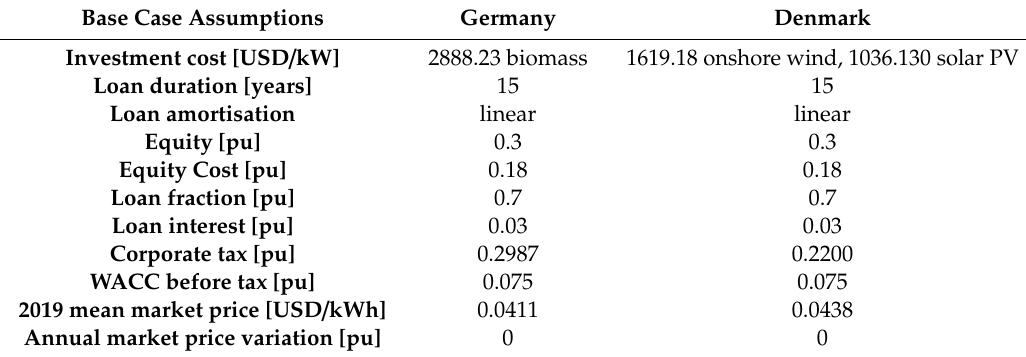
Table 3. Base case assumptions for the determination of the project and equity net present value (NPV) and internal rate of return (IRR) of the German biomass and the Danish onshore wind and solar photovoltaics (PV) auctions listed in Table 1. Source: